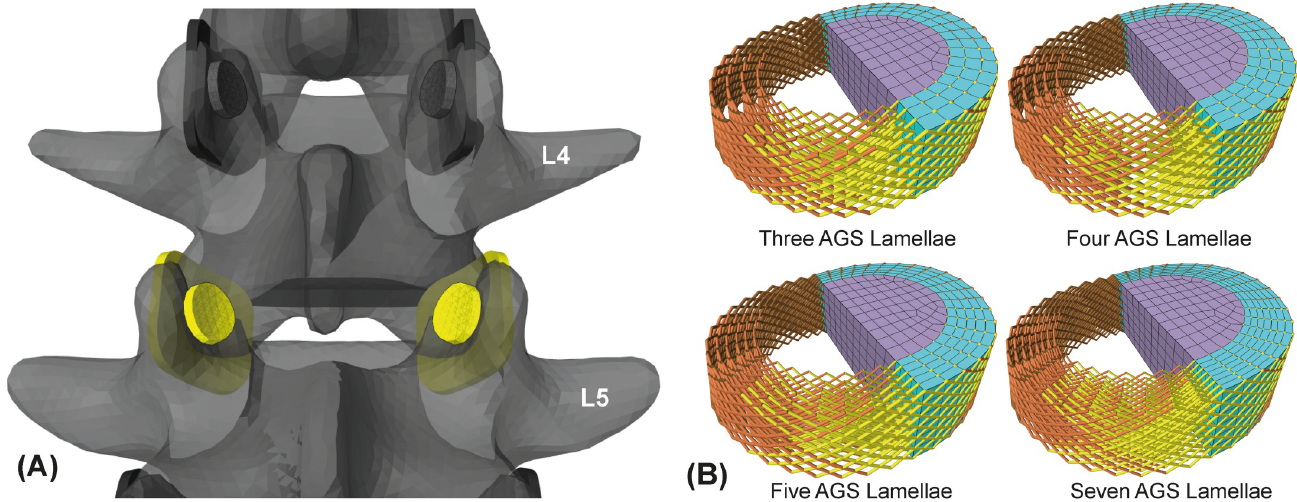
Fig 2. (A) Yellow highlighted L4/5 facet joints in dorsal view and (B) L4/5 disc variations. (A) Detailed view of the vertebral levels L3 to L5. Only rigid vertebrae and facet joints, which consist of the flexible inferior articular facets and rigid superior articular processes, are shown. (B) Varying disc discretizations for pre- calibration purposes. The L4/5 disc with three, four, five, and seven AGS lamellae corresponding to four, five, six, and eight CF rings is shown. FE meshes for AGS and NP are shown only for the left sides of the discs.